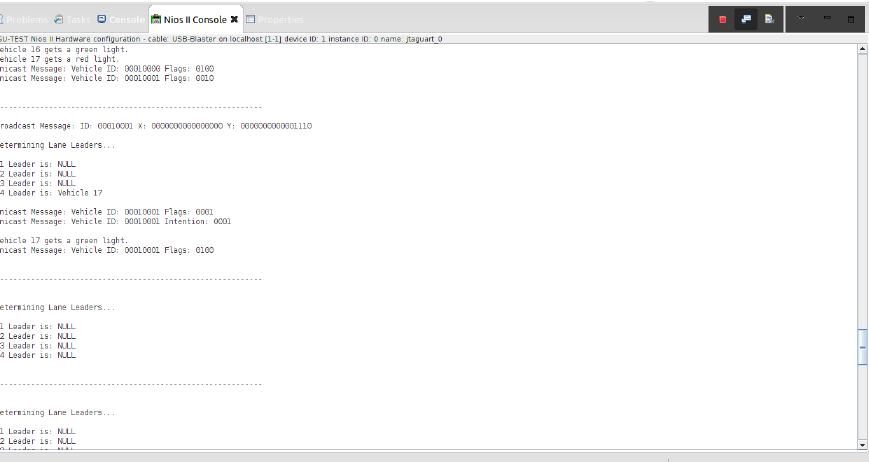
Figure 17. The above screenshot from the Nios II Eclipse Console demonstrates the successful traffic management of a single vehicle at the blind